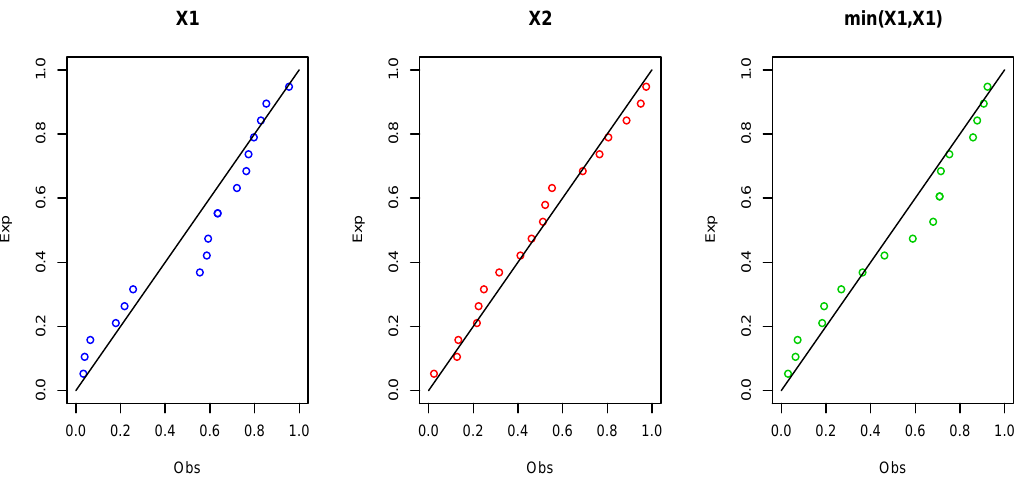
, X and min ( X 1 , X 2 and min ( X 1 , X 2 ) for data set II. 2 1